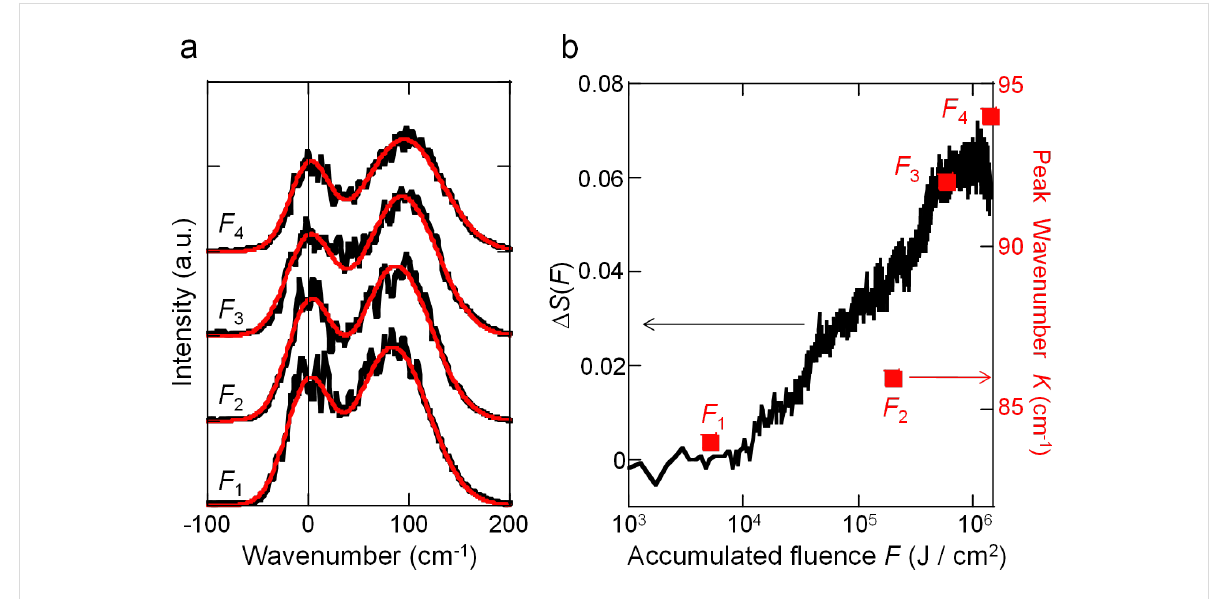
Figure 2: a) Wavenumber spectra of reflected light from silica substrate for accumulated fluences F 1 to F 4 , where F 1 = 5.1 × 10 3 J/cm 2 , F 2 = 1.9 × 10 5 J/cm 2 , F 3 = 5.9 × 10 5 J/cm 2 , and F 4 = 1.3 × 10 6 J/cm 2 . The black and red solid lines indicate the measured values and approximation curves given by the sum of two Gaussian functions, respectively. The vertical axis shows arbitrary units and the baselines of F 1 to F 4 are essentially equivalent. b) Dependence of relative increase in scattered light intensity, Δ S (black line), and peak wavenumber in reflected light spectra K (red squares) on accumulated fluence, F